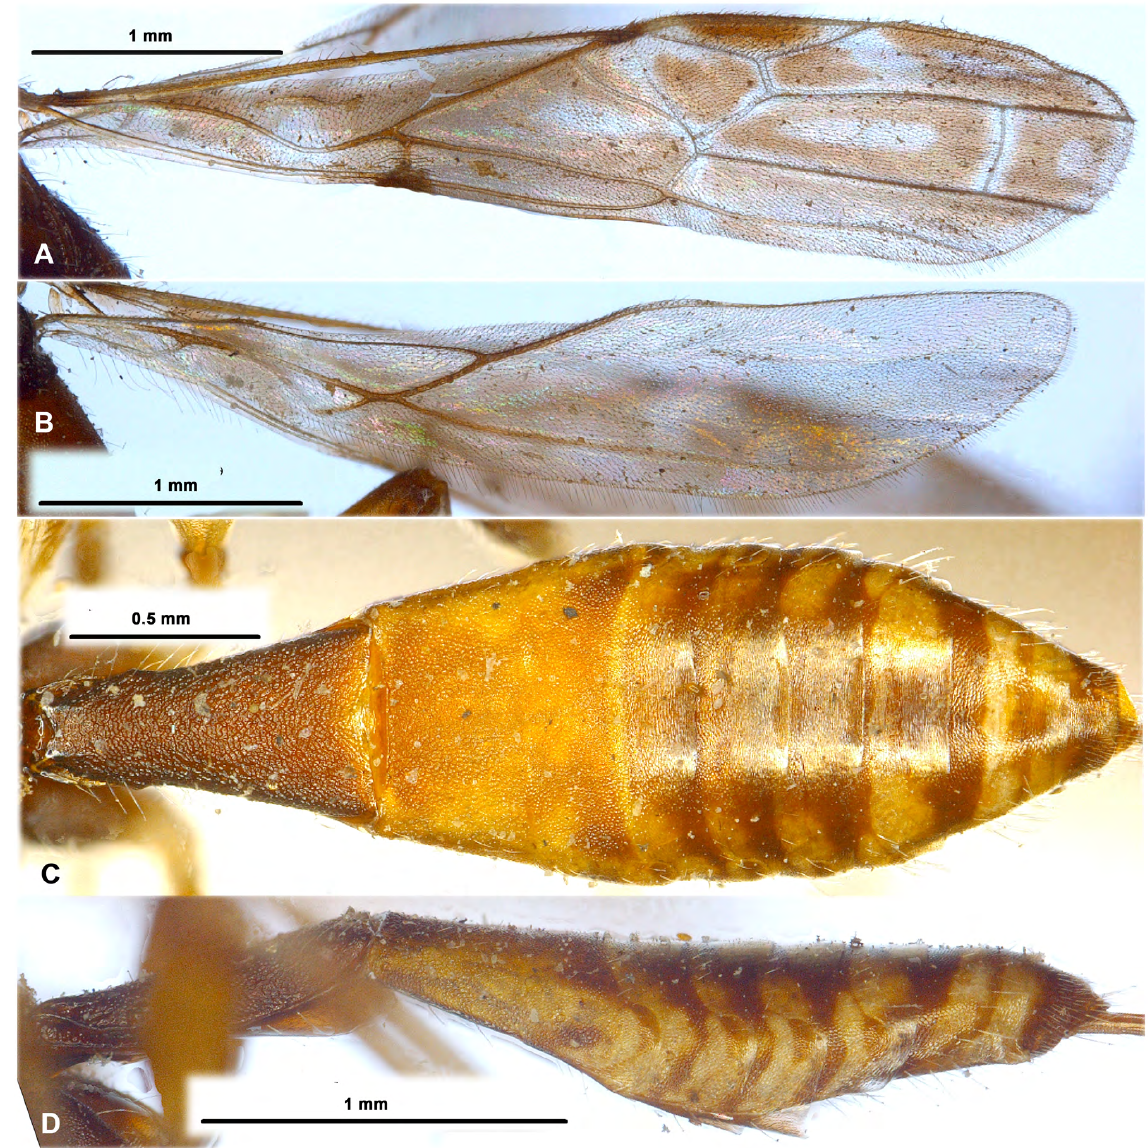
Fig. 37. Platyspathius ( Lenticularia ) lenticularis (Granger, 1949), ♀, holotype, MNHN. A . Fore wing. B . Hind wing, C . Metasoma, dorsal view. D . Metasoma, lateral